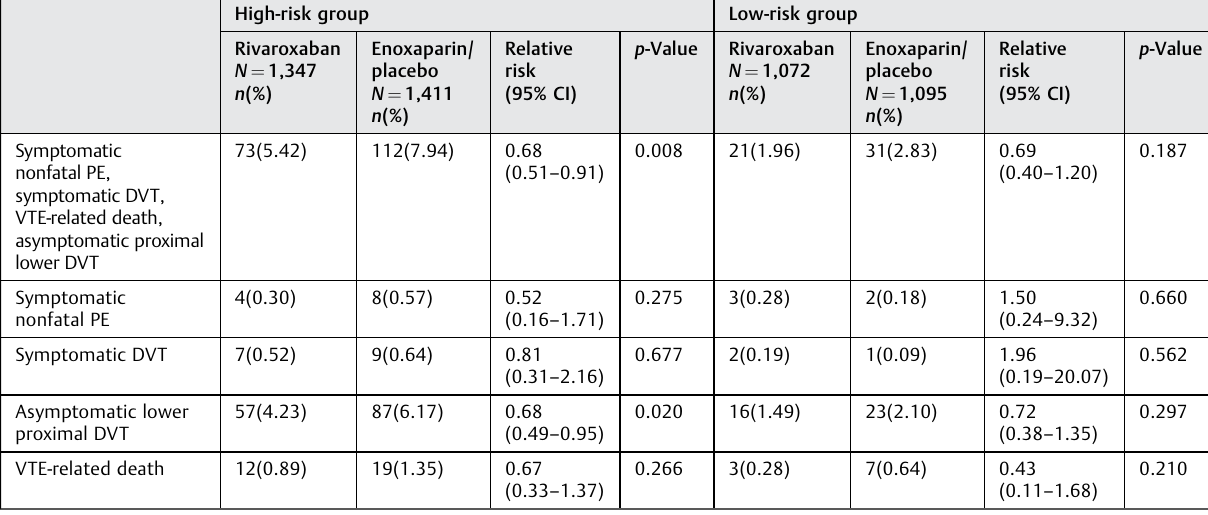
Table 3 Ef fi cacy endpoints (MAGELLAN subpopulation: mITT analysis set, day 35) High-risk group